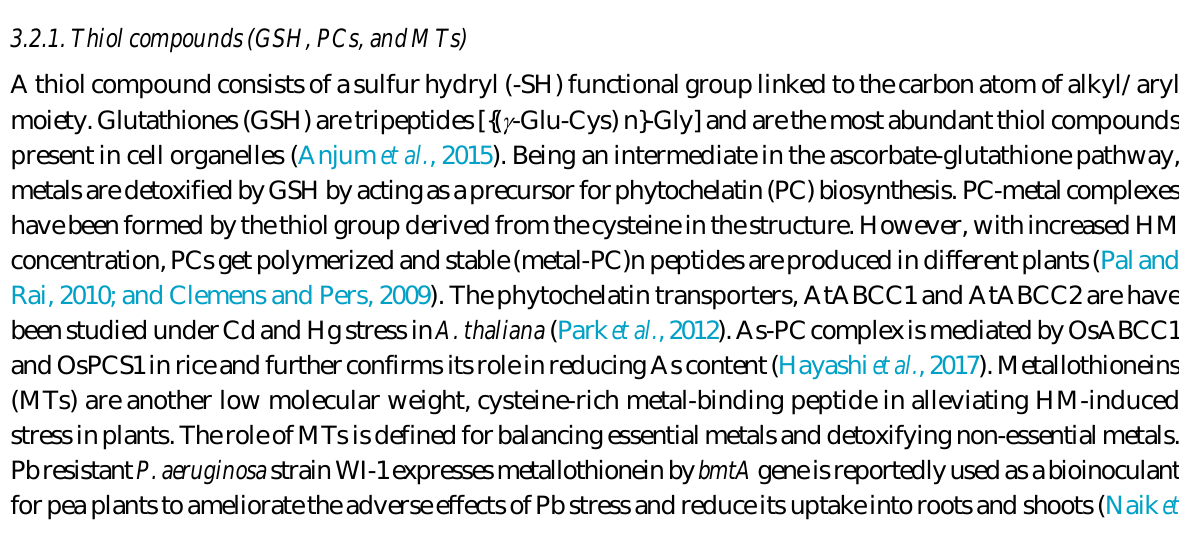
Table 2: Oxidative stress related genes/ enzymes that is modulated by exogenous melatonin under HM stress Heavy